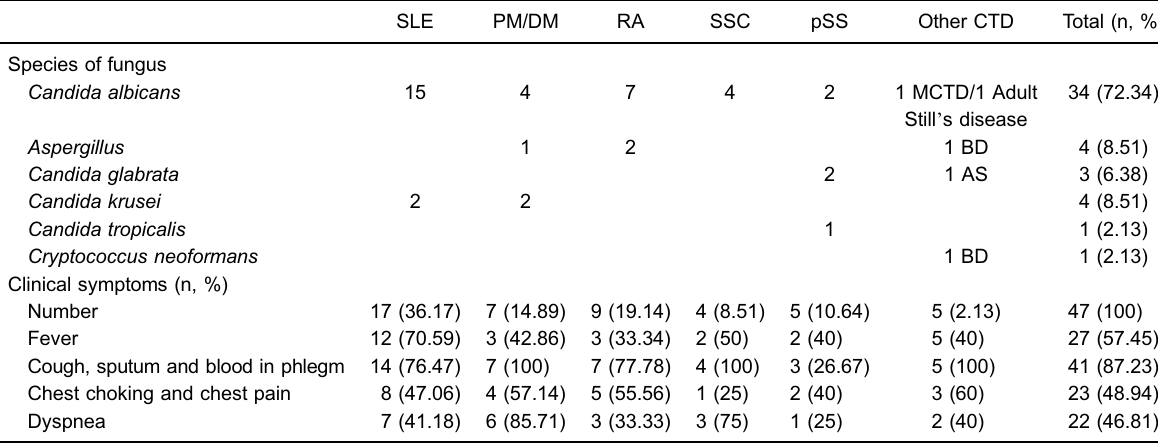
Table 2. Fungal species and onset of clinical symptoms in patients with connective tissue disease (CTD) associated with invasive pulmonary fungal infection with different diagnoses.